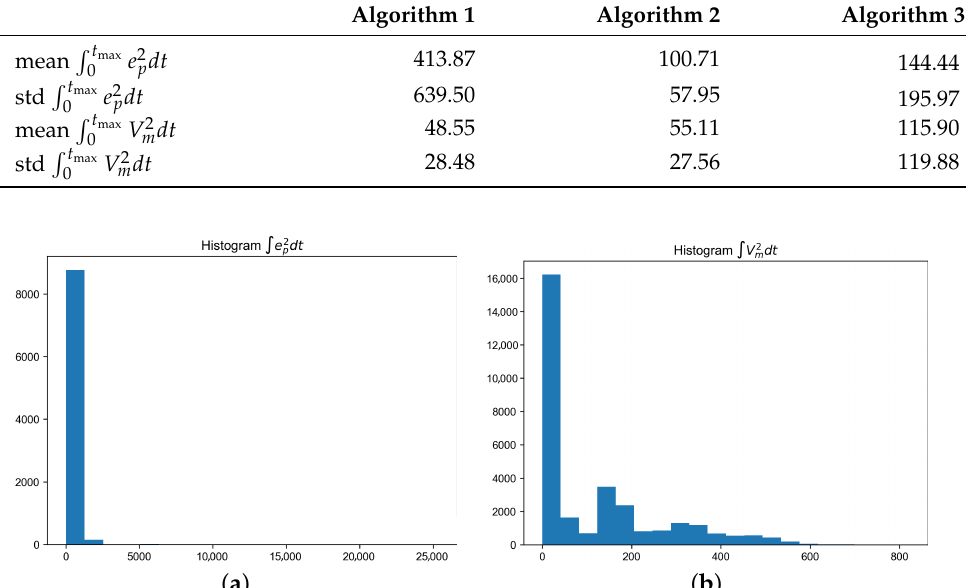
(cid:82) (cid:82) e 2 p dt , ( b ) V 2 m dt